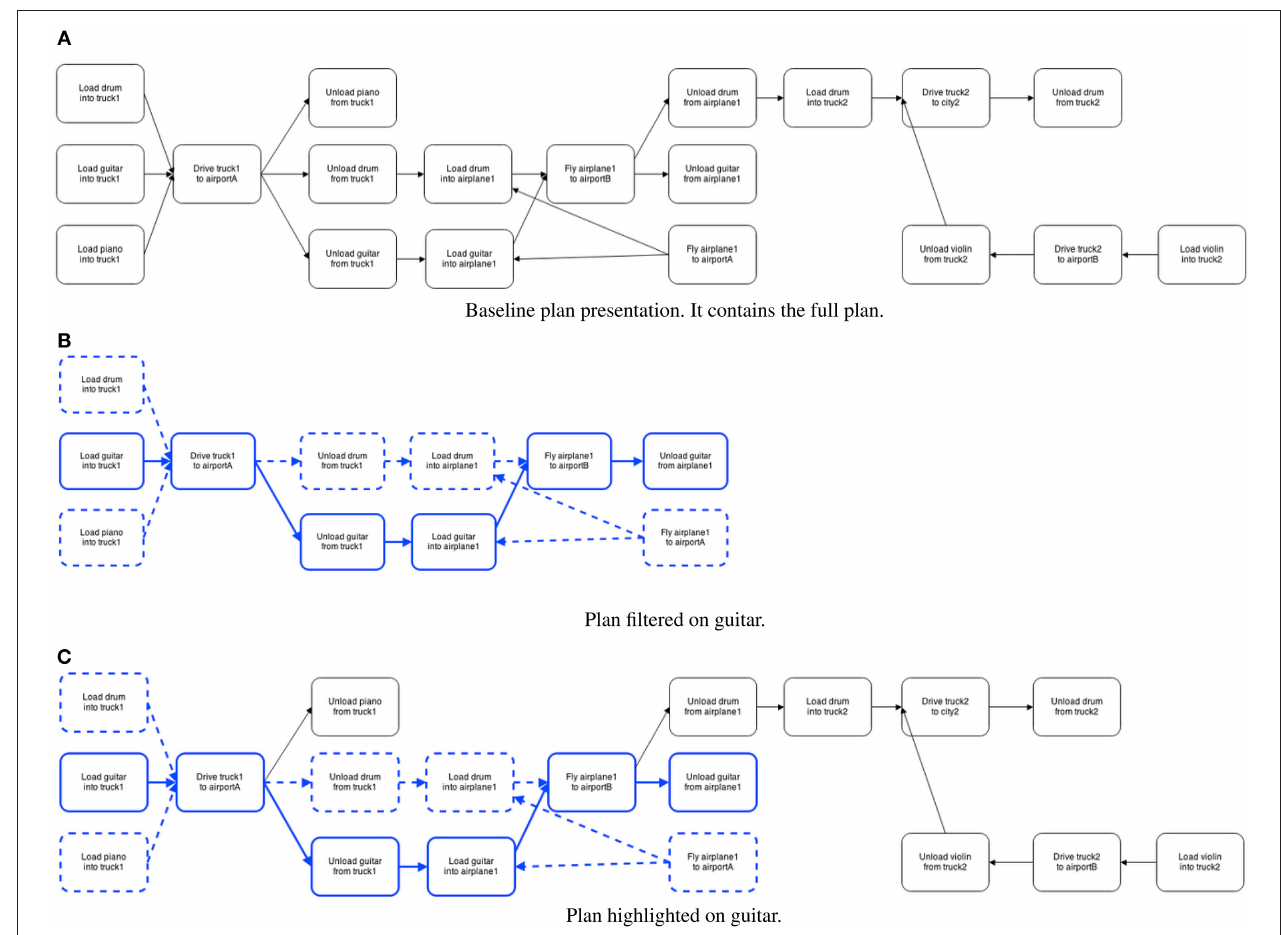
FIGURE 6 | Experiment 4, the three conditions. Baseline, and also highlighting vs. filtering of the plan on “guitar.” Emphasis is marked by a thicker and colored (blue) border. Dependencies are indicated by dotted lines. (A) Baseline plan presentation. It contains the full plan. (B) Plan filtered on guitar. (C) Plan highlighted on guitar.